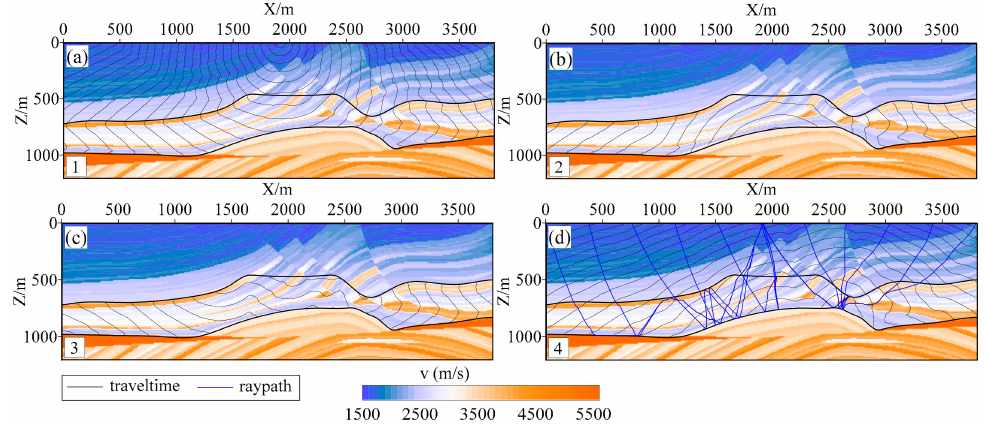
Figure 13. MFMM multiple wave ray tracing. The wavefront of ( a ) the down-going wave from the source to interface 2, ( b ) the up-going wave from interface 2 to interface 1, ( c ) the down-going wave from interface 1 to interface 2, ( d ) the up-going wave from interface 2 to surface and the whole raypath.